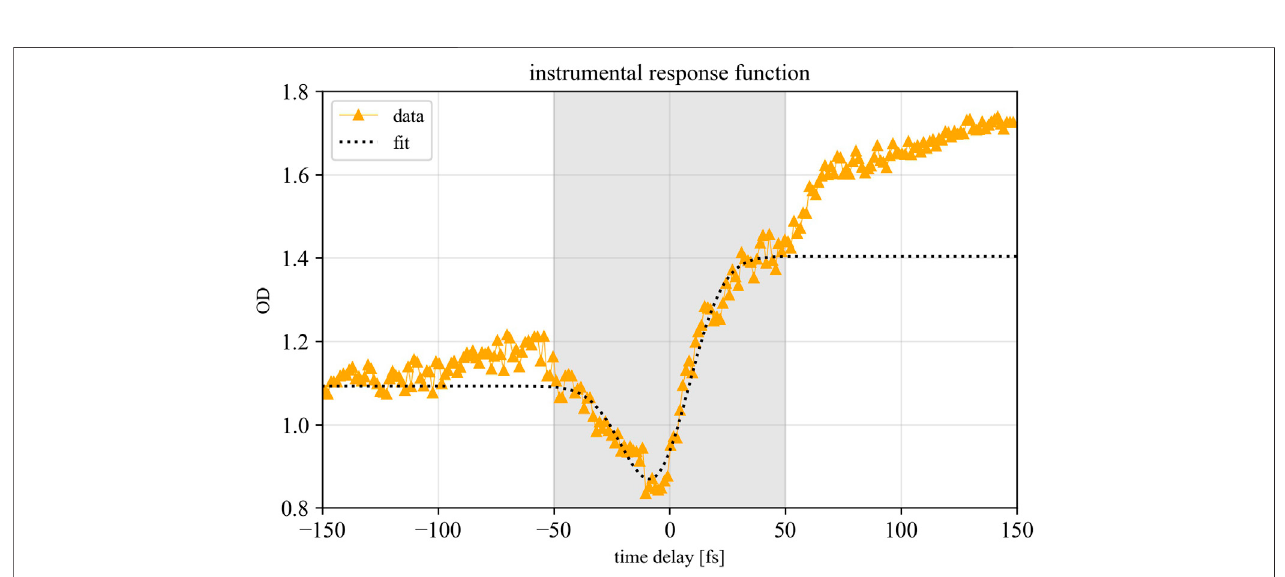
FIGURE 3 | Fit of the instrumental response function on the mean lineout of the Q3-band as a function of the time delay. The fi t function (1) was applied in the grey shaded pulse-overlap area.